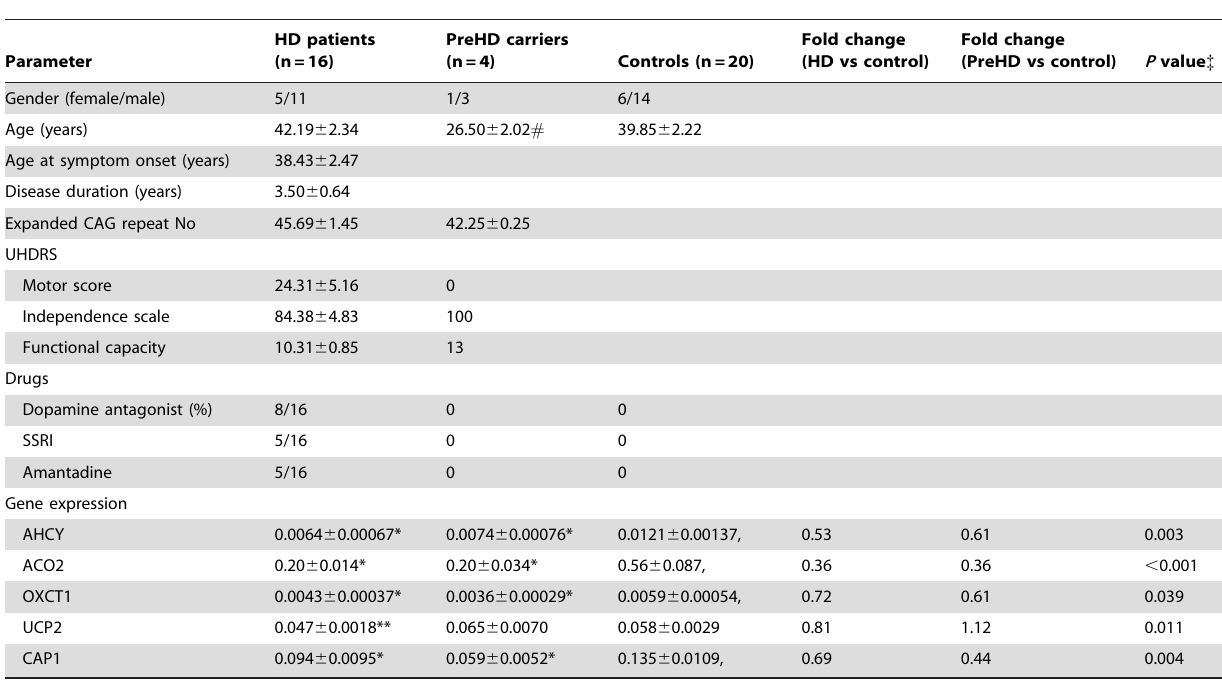
Table 2. Clinical characteristics and gene expression levels of the symptomatic HD patients, PreHD carriers and the controls.